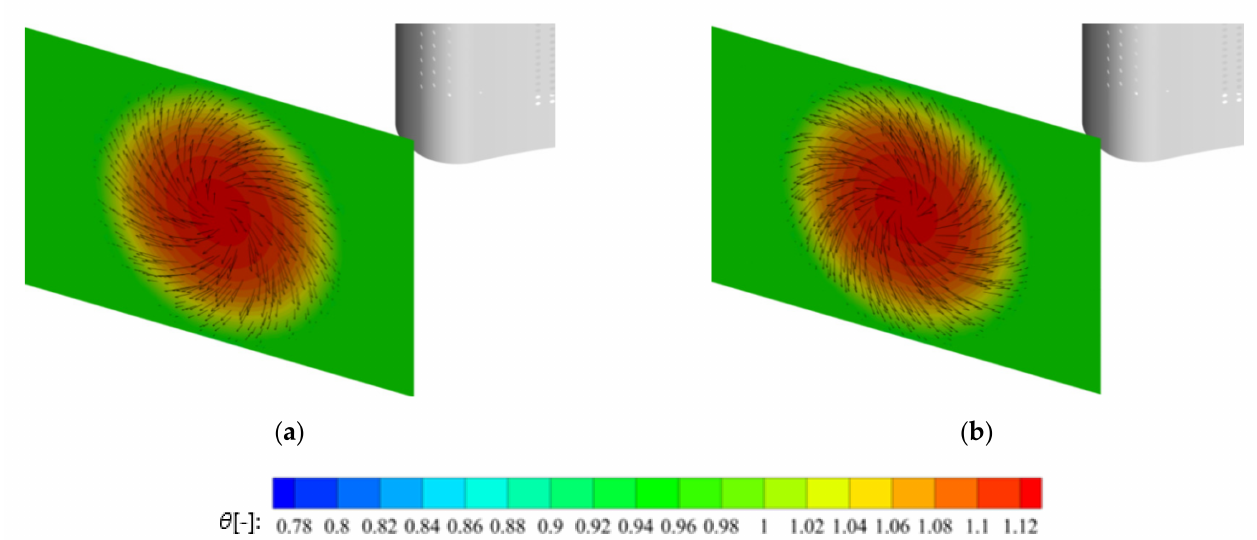
Figure 6. Hot streak and velocity vectors distribution at the stage inlet plane. ( a ) Case 3: HS and positive swirl; ( b ) Case 4: HS and negative swirl.